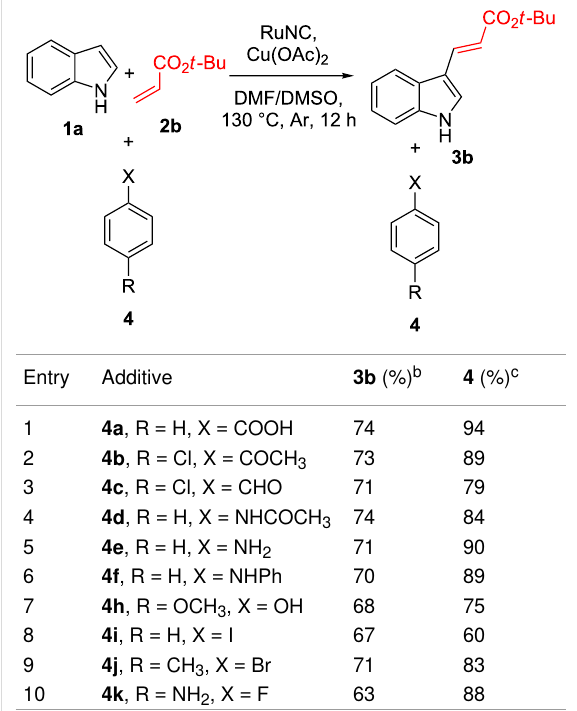
Table 2: Robustness screen of the synthesis of 3-alkenylindole 3b .